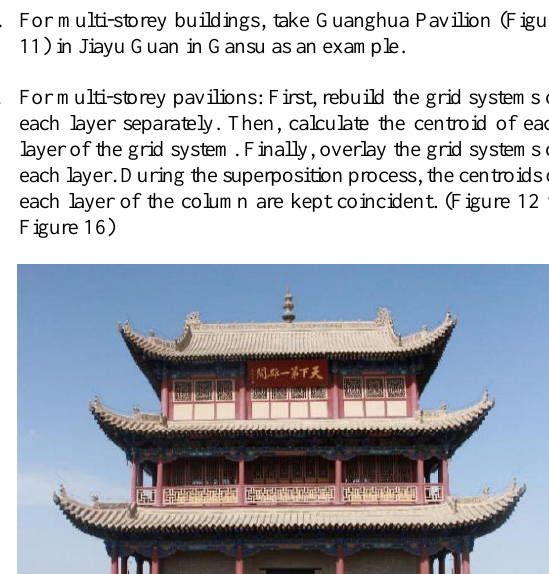
Figure 12. the plan of Guanghua Pavilion